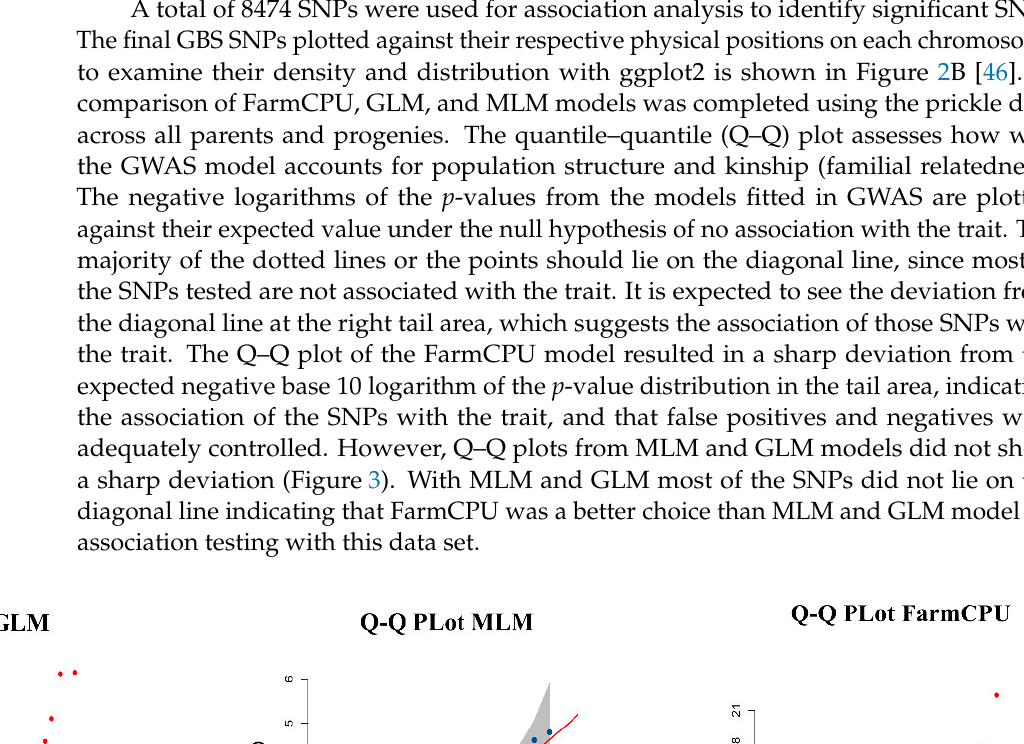
( B ) Figure 2. ( A ) Distribution of prickles in F 1 progeny generated from hybridization between prickle-free ‘Joan J’ ( ss ) and prickled ‘Caroline’ ( Ss ) (46:44) and ( B ) distribution of single nucleotide polymorphisms (SNPs) in 1 Mb window size across the raspberry chromosomes. The x-axis represents the distance in base pairs.